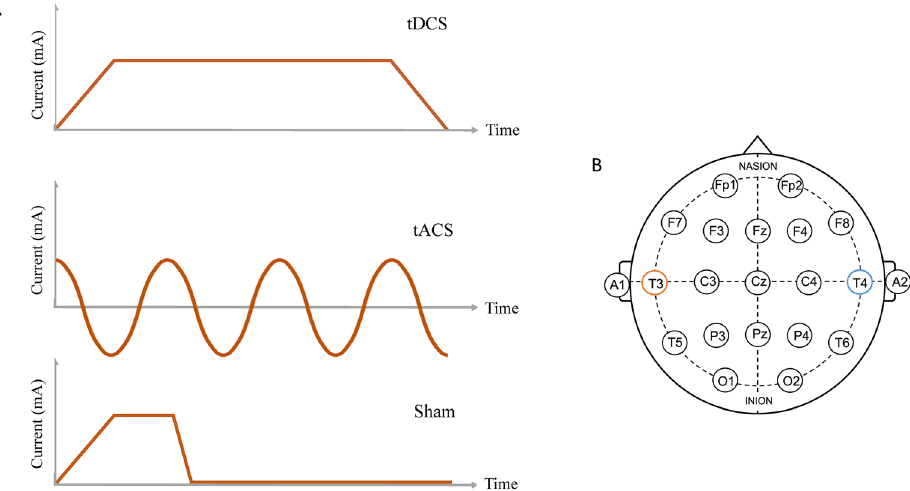
Figure 1. ( A ) Different stimulation types utilised within the study: transcranial direct current stimulation (tDCS), transcranial alternating current stimulation (tACS) and sham stimulation. ( B ) International 10–20 EEG electrode arrangement with the anodal electrode (T3) in orange and the cathodal/reference electrode (T4) in